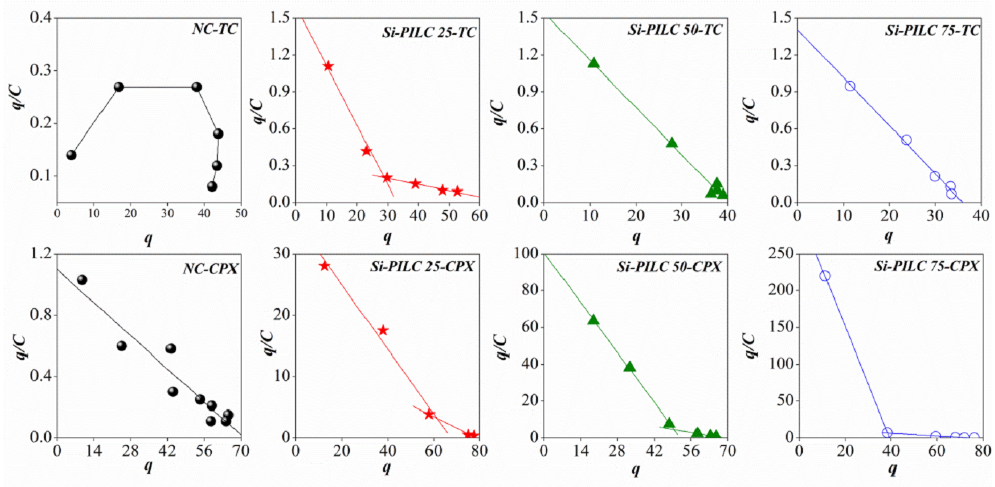
Figure 10. Scatchard plots derived for adsorption data obtained for two antibiotics and the four